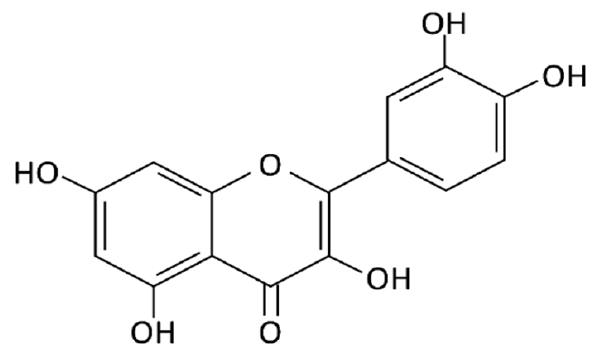
Figure 2. Chemical structure of